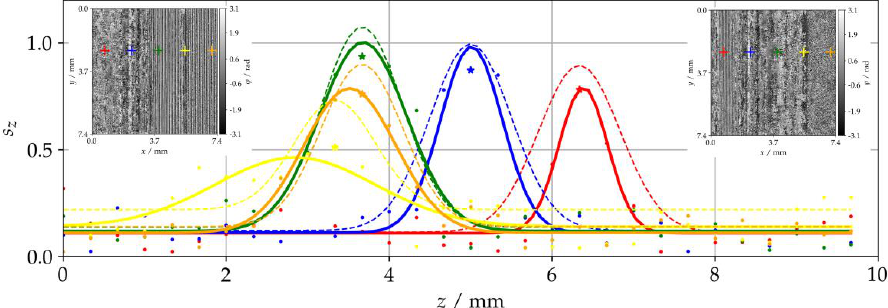
Figure 6. Phase smoothness 𝑠 𝑧 of several points at different propagation distances, 𝑧 . 𝑧 𝑜𝑝𝑡,𝑚𝑎𝑥 is marked with a ∗ , whereas 𝑧 𝑜𝑝𝑡,𝐺𝑎𝑢𝑠𝑠 can be read at the peak of the Gaussian fit. Two thumbnails at 𝑧 = 3.50 mm (left) and 𝑧 = 6.33 mm (right) illustrate the position of the crosses on the sample near the focus or the orange cross (left) and the red cross (right).